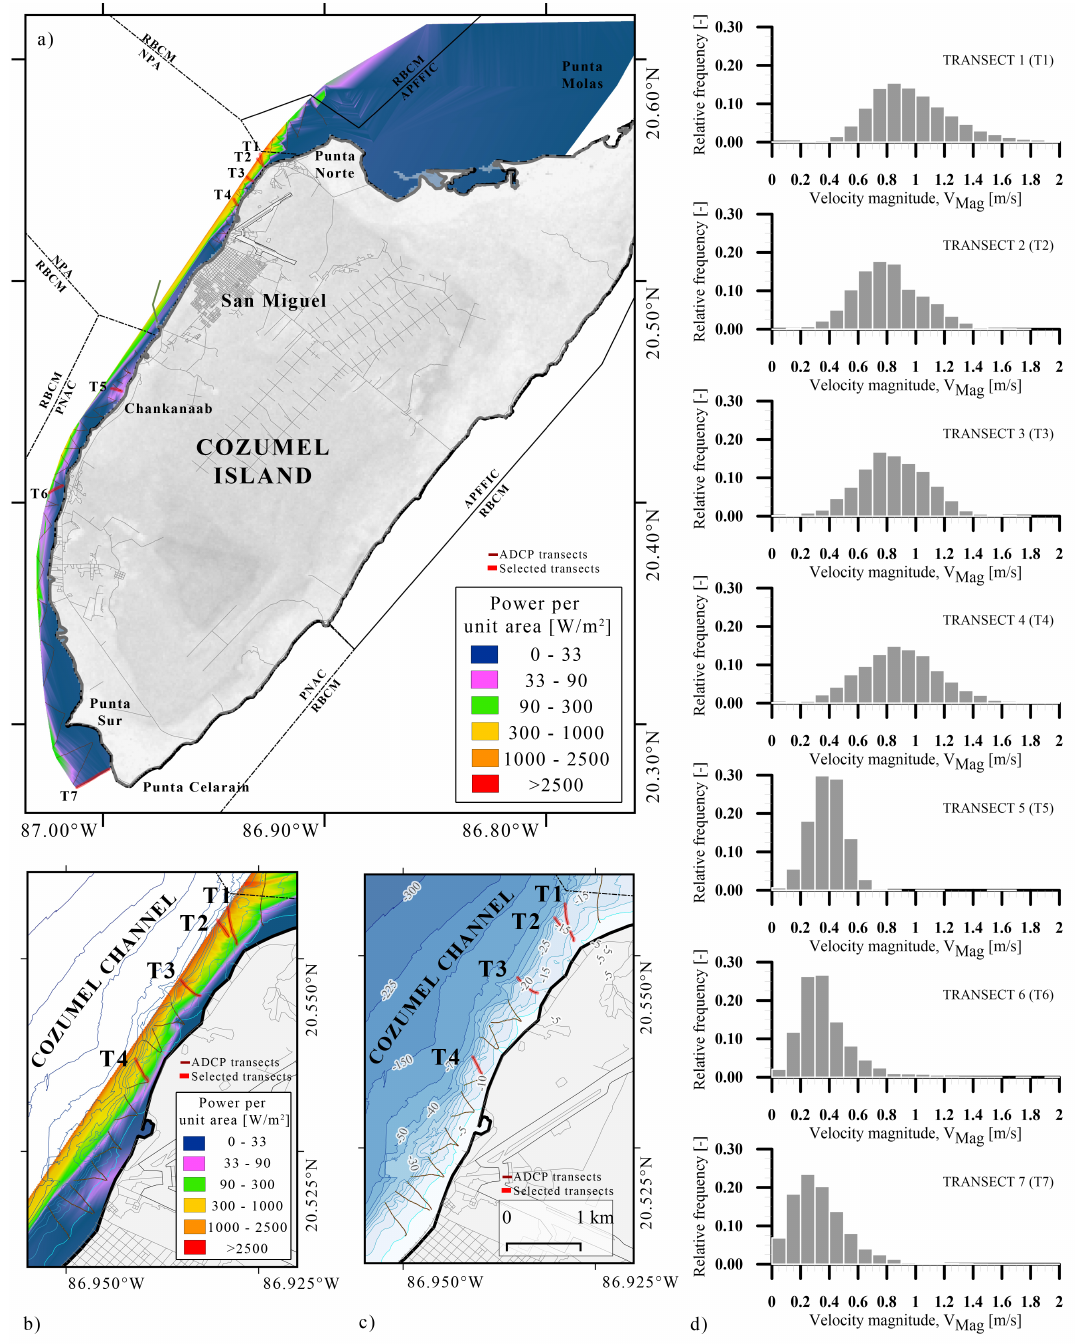
Figure 5. Power per unit area based on ADCP in-situ measurements for: ( a ) the shallow east coastal waters of the Cozumel Channel; and ( b ) Zone Z2 (latitudes ∼ 20.53° N–20.57° N). Bathymetric details in Zone Z2 are shown in ( c ) for the selected Transects T1–T4. Histograms are shown in ( d ) for different Transects T1–T7 along the west coast of Cozumel Island. Histograms of velocity magnitude from ADCP measurements at different transects distributed along the west side of the Cozumel Island are shown in Figure 5d. Velocity magnitudes varied from 0.34 m s − 1 to 1.04 m s − 1 (Table 1), with average among transects of 0.71 m s − 1 ( σ = ± 0.23). The lower velocities were observed closer to the coastline, and the higher velocities occur close to the limit edge of the insular shelf (Figure